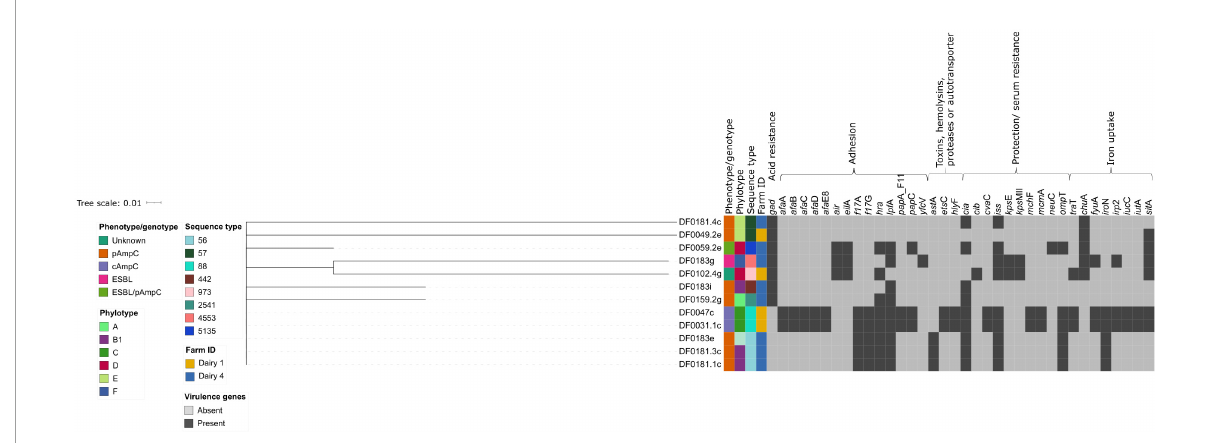
FIGURE3 Hierarchical cluster tree constructed using Jaccard distances for the presence or absence data from 37 virulence genes identified using Virulence Finder. The tree was edited using the Interactive Tree of Life webserver. Isolate metadata is included for ESBL or AmpC phenotype, farm and sequence type, as indicated by the colour keys. The virulence genes are grouped and annotated by general function.